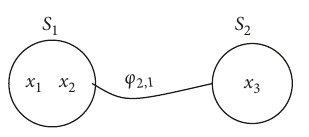
Figure 5: Superhypergraph H � ( X, S